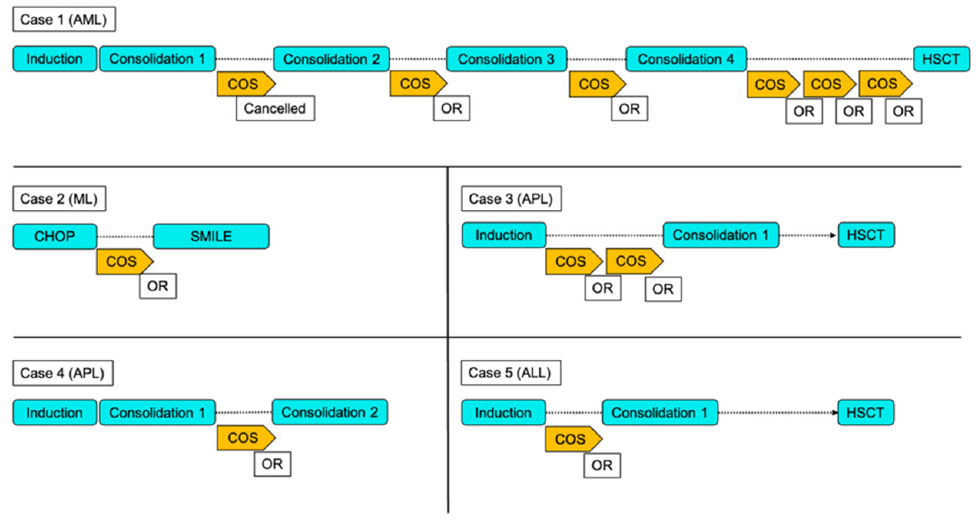
Figure 1. Treatment course of individual chemotherapy and oocyte retrieval . AML: Acute myeloid leukemia ML:Malignant Lyphoma APL: Acute promyelocytic Leukemia ALL: Acute lymphocytic leukemia OR: oocyte retrieval COS: Controlled ovarian stimulation HSCT: Hematopoitic stem cell transplantation